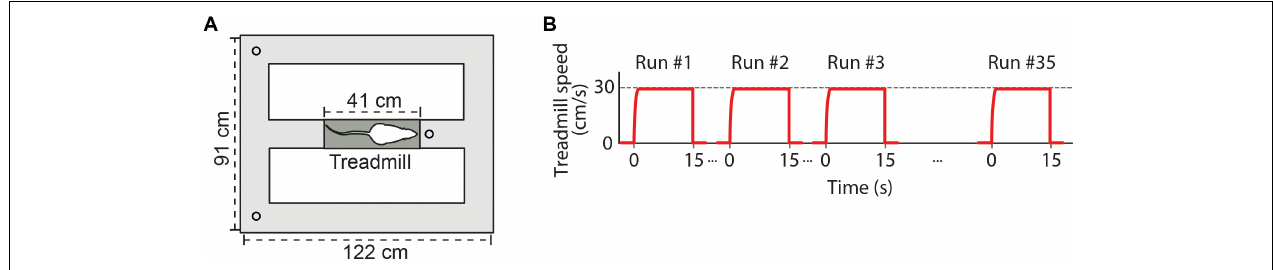
FIGURE 1 | Experimental design. (A) Schematic representation of the apparatus showing the treadmill (dark gray) placed in the central stem of an eight-shape maze (light gray). Circles at each side of the maze and ahead of the treadmill denote ports to deliver drops of water. (B) The exercise protocol required rats to perform voluntary 15-s runs on the treadmill at a constant speed of 30 cm/s. Red lines represent instantaneous treadmill speed across subsequent runs. Inter-running intervals depended on the time the animal spent to complete a lap on the maze. Recording sessions with at least 35 runs on the treadmill were analyzed.